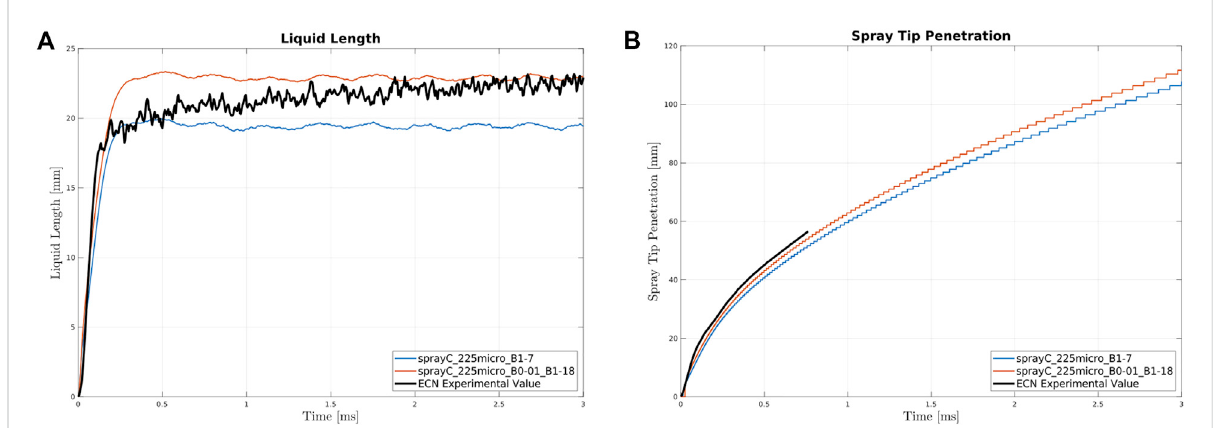
Figure A1 and Figure A2 reported vapor penetration and liquid length of Spray C and Spray D in RANS with fi ne tuning of the